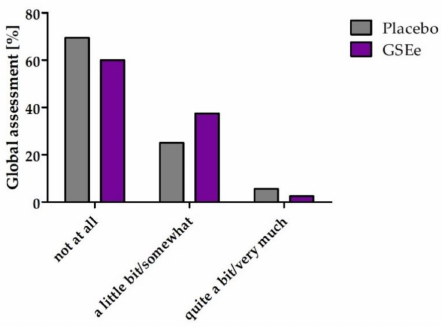
Figure 6. Global assessment 16 weeks after (V3), as general health perception due to intervention. Global assessment in percentage of GSEe (in purple) vs. placebo (in grey) evaluated by three answer